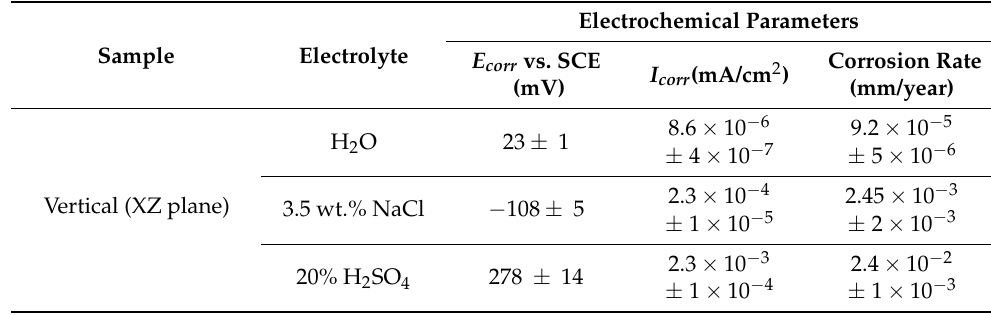
Table 4. Electrochemical parameters of the SLMed 316L SS tested in vertical (XZ plane).